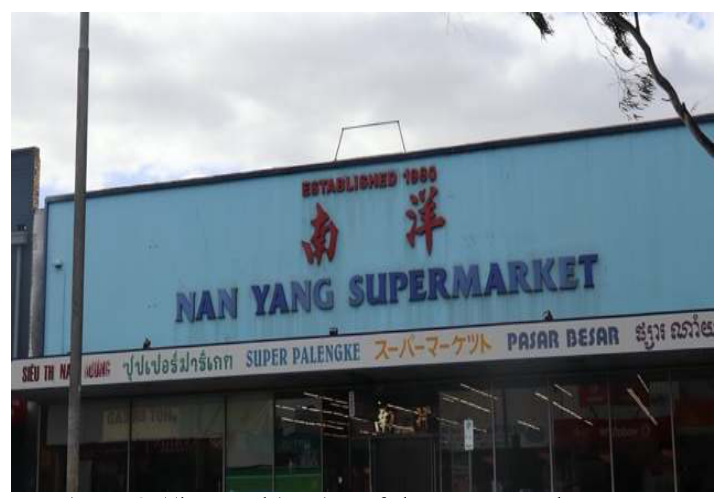
Figure 3. The combination of three or more